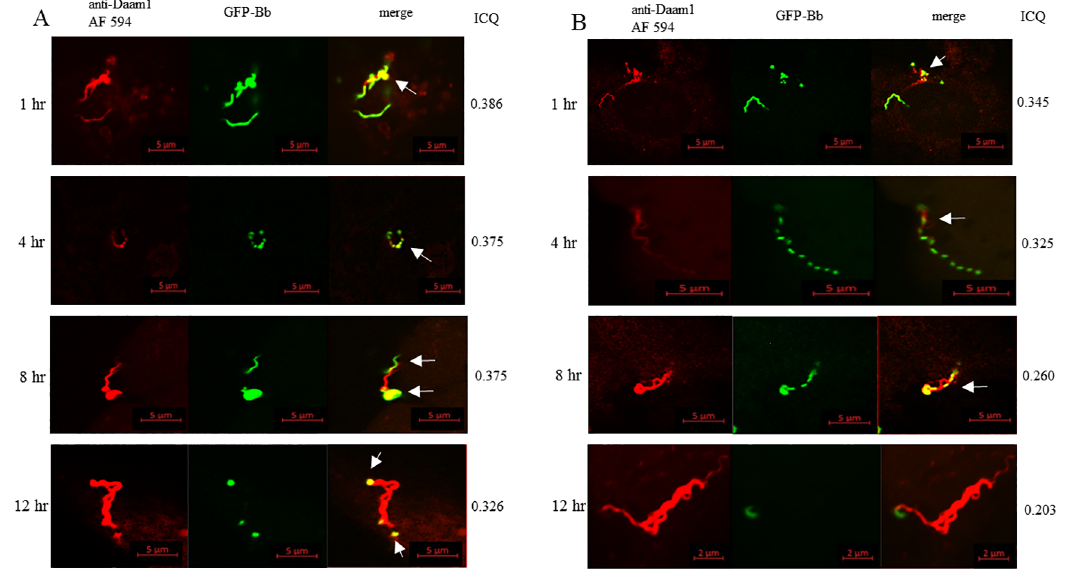
Fig 1. H4 and HS683 cells internalize B . burgdorferi by coiling phagocytosis. Coiling phagocytosis of B . burgdorferi by H4 and HS683 neuroglial cells viewed at 63X magnification after 1, 4, 8, and 12 hrs post-coincubation. A) H4 cells incubated with B . burgdorferi ; B) HS683 incubated with B . burgdorferi . Fields are: left panel) anti-Daam1 stained with Alexafluor 594 (red); middle panel) GFP- B . burgdorferi (green); right panel) merged image. Note that after a few hours incubation, Daam1 enriched pseudopods engulf the spirochetes. Yellow in merged images indicate Daam1 colocalizing with B . burgdorferi outer membrane (arrows). ICQ values are denoted quantifying colocalization as described in Methods.